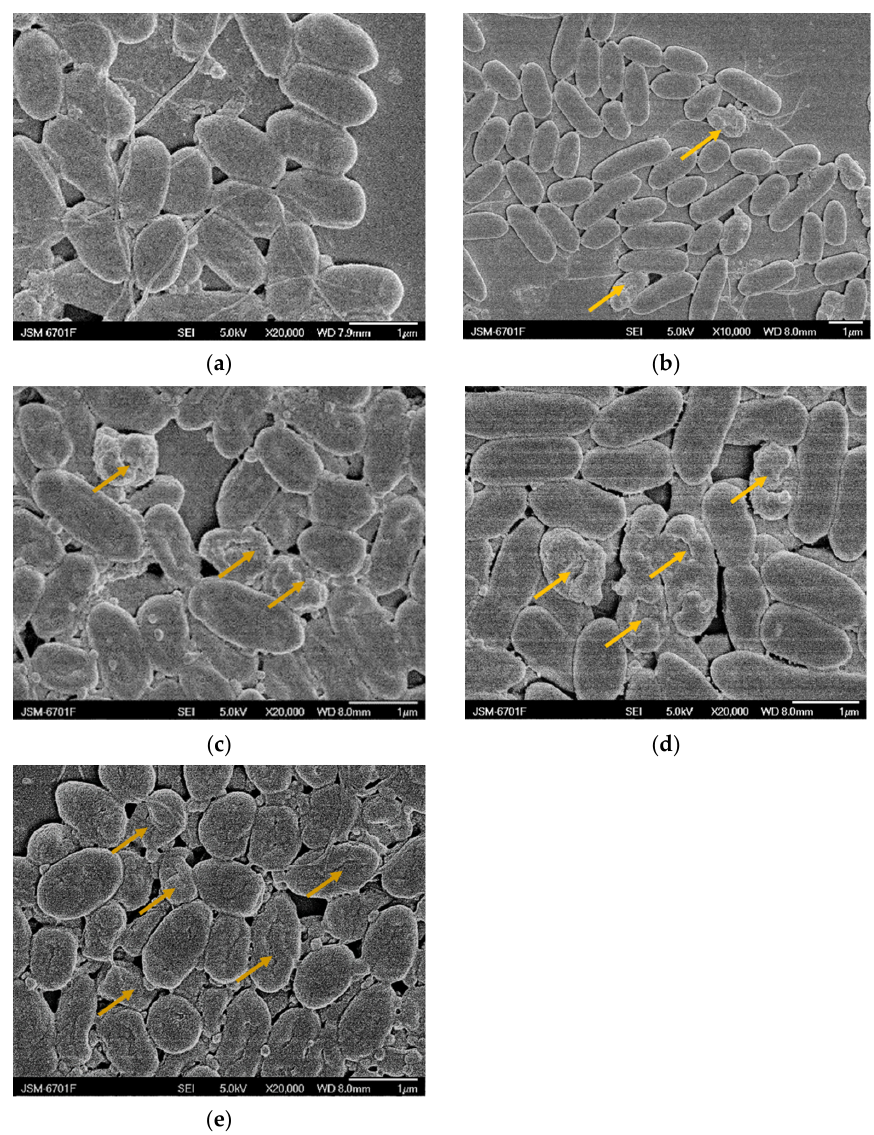
Figure 5. SEM images of Pcc S1 untreated ( a ) and treated by 1/8 × MIC ( b ), 1/4 × MIC ( c ), 1/2 × MIC ( d ) and 1 × MIC RTMBE ( e ). The yellow arrows represent sunken and irregular bacterial surfaces.